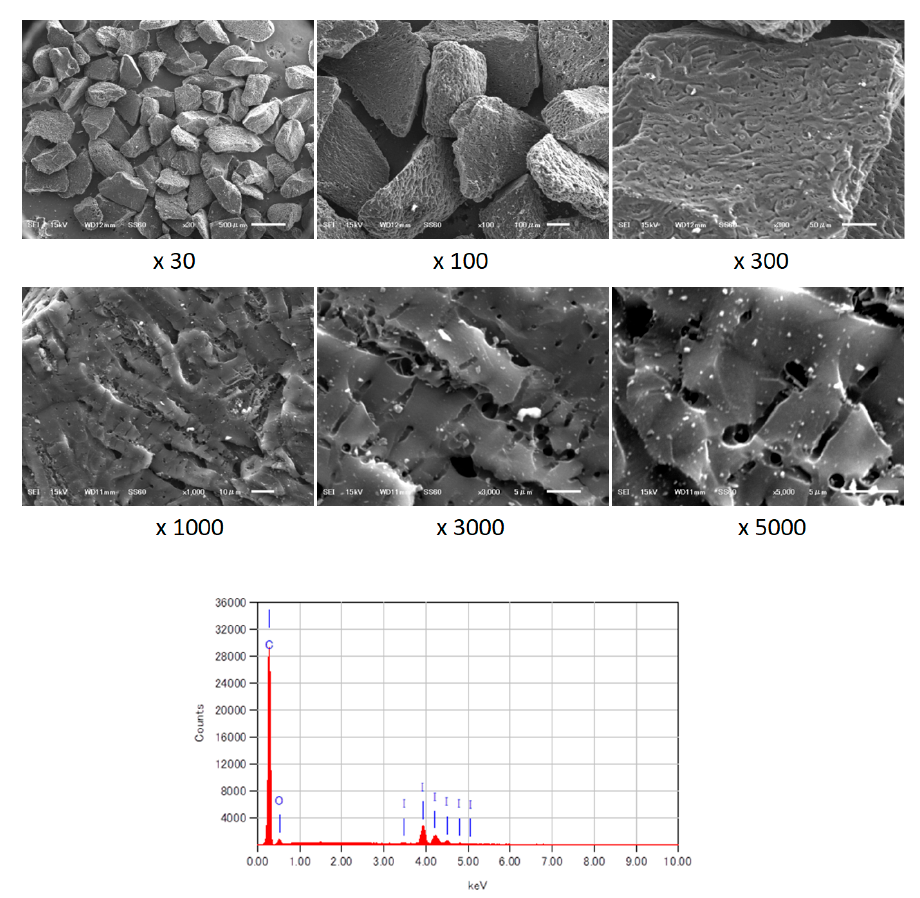
Figure 1. SEM images (various magnifications) and EDS elemental analysis of elementary iodine impregnated activated carbon (IodAC).